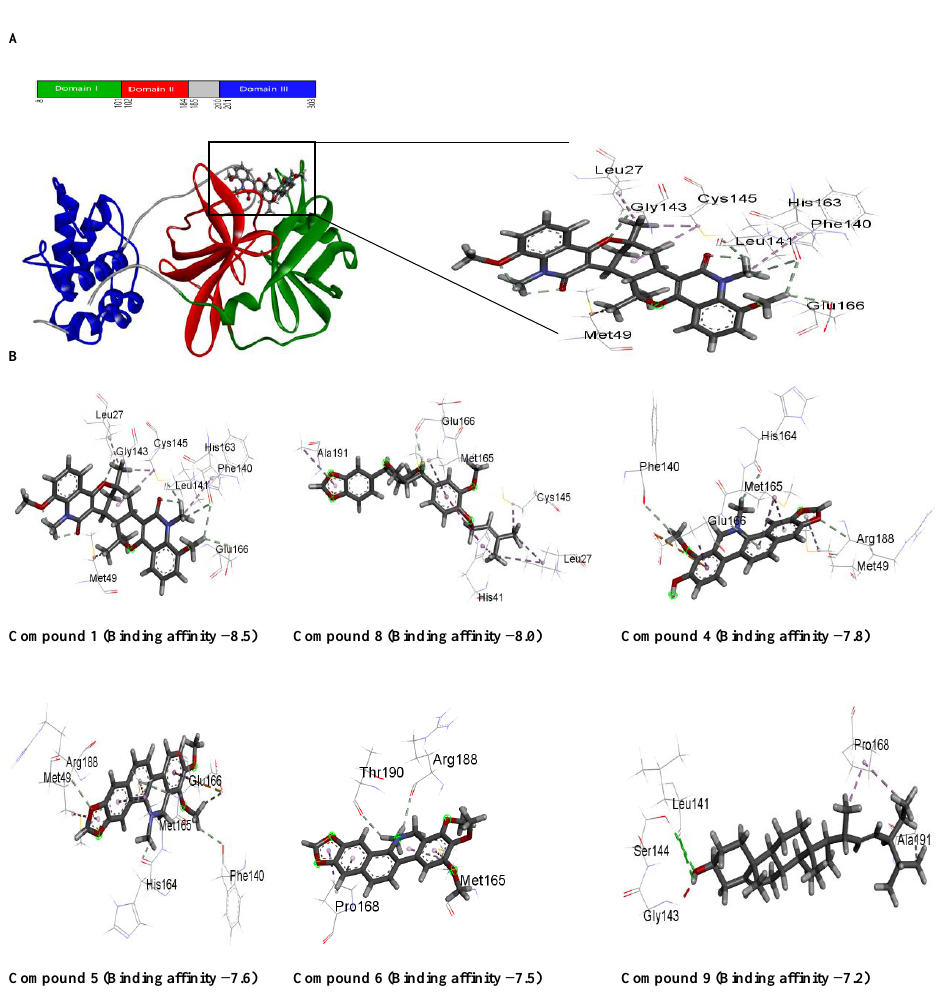
Figure 3. ( A ) Schematic 1D amino acid sequence of main protease and interaction of main protease with Compound 1 . ( B ) Interaction of main protease with different Compound and binding affinity. Table 3. Non-covalent interactions of isolated compounds with Mpro (PDB ID 6LU7) (Pose pre- dicted by AutoDock Vina).